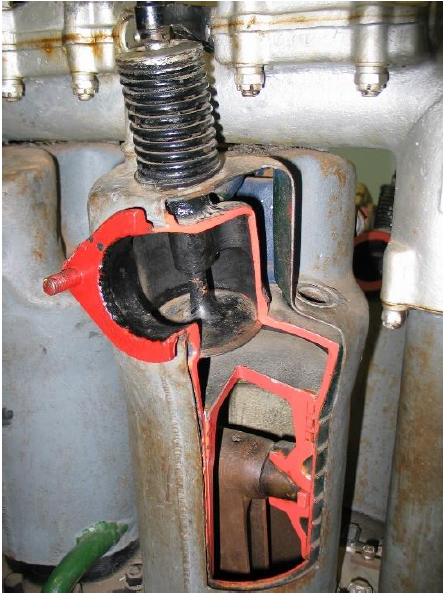
Fig. 3. Combustion chamber of the Liberty V-12 engine (The Tank Muse- um at Bovington Camp in Dorset, photo by the